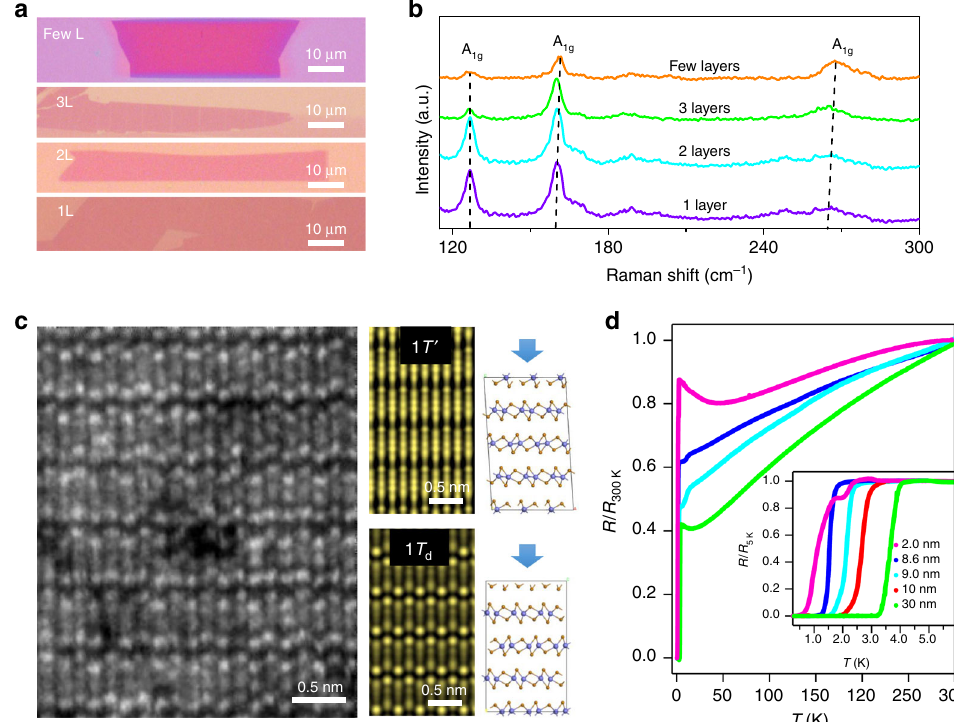
Fig. 1 Structural and transport characterization of the as-synthesized 1 T d -MoTe 2 samples. a Optical images of monolayer (1L), bilayer (2L), trilayer (3L), and few layers of as-synthesized MoTe 2 . The size of the monolayer sample can reach up to 100 µ m. The scale bar is 10 µ m. b Raman spectra of the few- layer MoTe 2 samples. Raman peaks were observed at 127, 161, and 267 cm − 1 , corresponding to the Ag modes of 1 T d -MoTe 2 . c Atomic resolution scanning transmission electron microscopy (STEM) image of few-layer 1 T d -MoTe 2 . Simulated STEM images of few-layer MoTe 2 in 1 T ′ and 1 T d stacking viewed along [0 0 1] zone axis are shown next to the experimental image, respectively. Compared with the simulation, the stacking of the few-layer MoTe 2 is con fi rmed to be the 1 T d phase. The scale bar is 0.5 nm. d Superconductivity in few-layer 1 T d -MoTe 2 . The inset shows the temperature dependence of the reduced four-terminal resistance ( R / R 5K ) in the range from 0.3 to 4.5 K, for MoTe 2 devices with the thickness ranging from 2 to 10